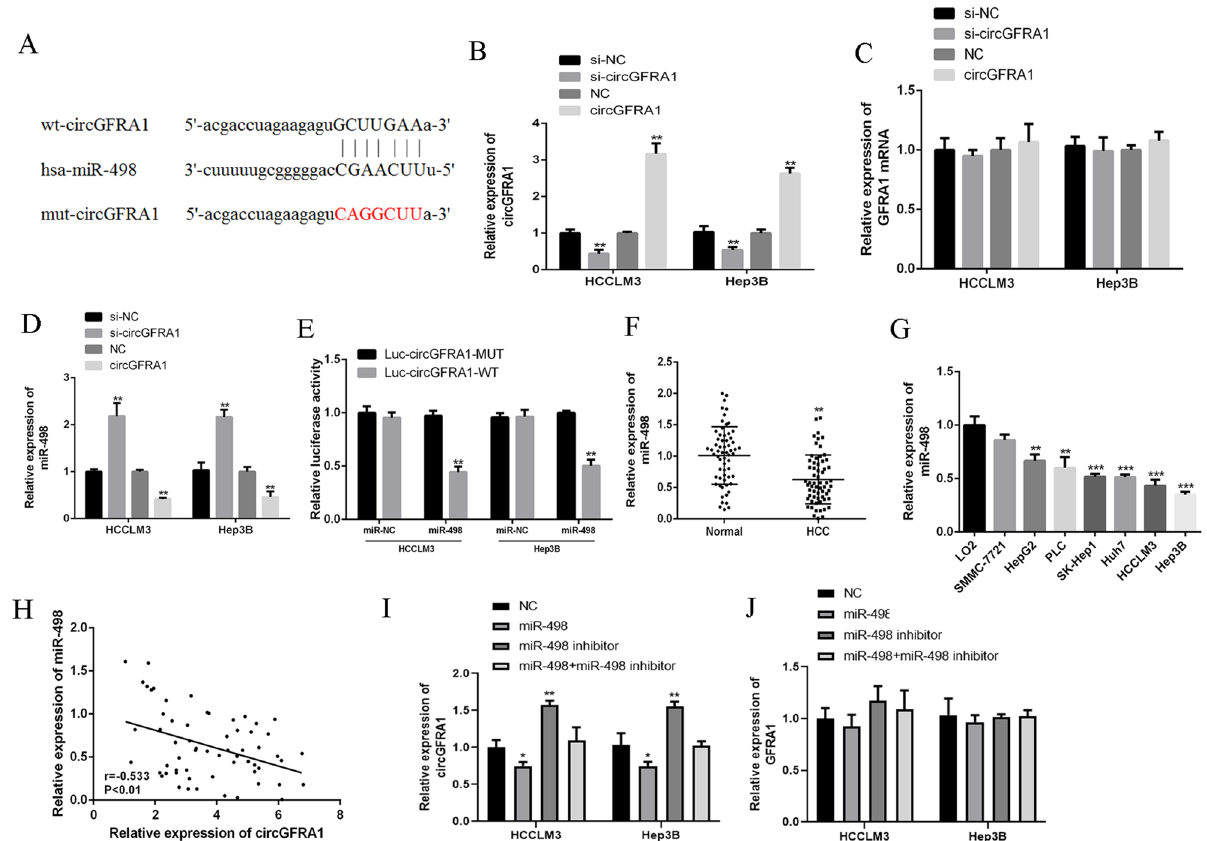
Figure 2. CircGFRA1 sponged miR-498 in HCC cell lines. ( A ) The common binding sequence of circGFRA1 and miR-498 by Starbase. ( B – D ) The expression of circGFRA1, GFRA1 mRNA and miR-498 by qRT-PCR in HCCLM3 and Hep3B cells transfected with si-circGFRA1 or circGFRA1. ( E ) Luciferase activity analysis in HCCLM3 and Hep3B cells co-transfected with miR-498 mimics and circGFRA1-WT or circGFRA1-MUT. ( F ) qRT-PCR for miR-498 in HCC tissues and normal tissues (n = 62). ( G ) qRT-PCR for miR-498 in HCC cell lines and normal liver cell line. ( H ) Pearson’s correlations between circGFRA1 and miR-498 in HCC tissues (n = 62) (r = -0.533, P < 0.01). ( I ) and ( J ) The expression of circGFRA1 and GFRA1 mRNA by qRT-PCR in HCCLM3 and Hep3B cells transfected with miR-498 mimics or inhibitor. *P < 0.05, **P < 0.01, ***P <